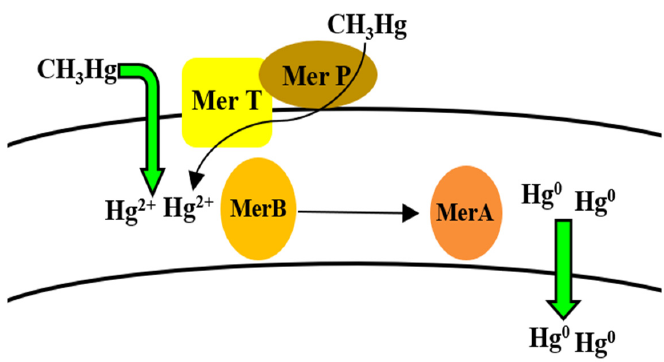
Figure 8. Uptake and reduction mechanisms for mercury by Bacillus spp.